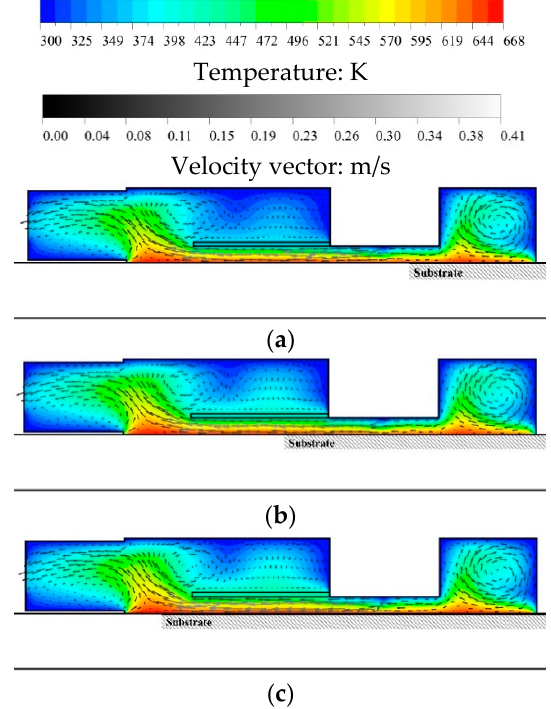
Figure 12. Velocity vector coupled with temperature contour of CdTe growth at a time of 180 s with susceptor moving speeds of: ( a ) 0.75 cm/min; ( b ) 1.50 cm/min; ( c ) 2.25 cm/min.